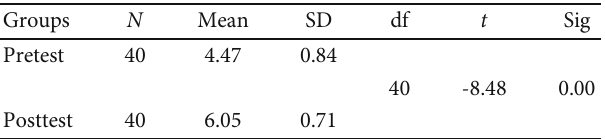
Table 4: Comparison of the experimental group ’ s pretest-posttest results.